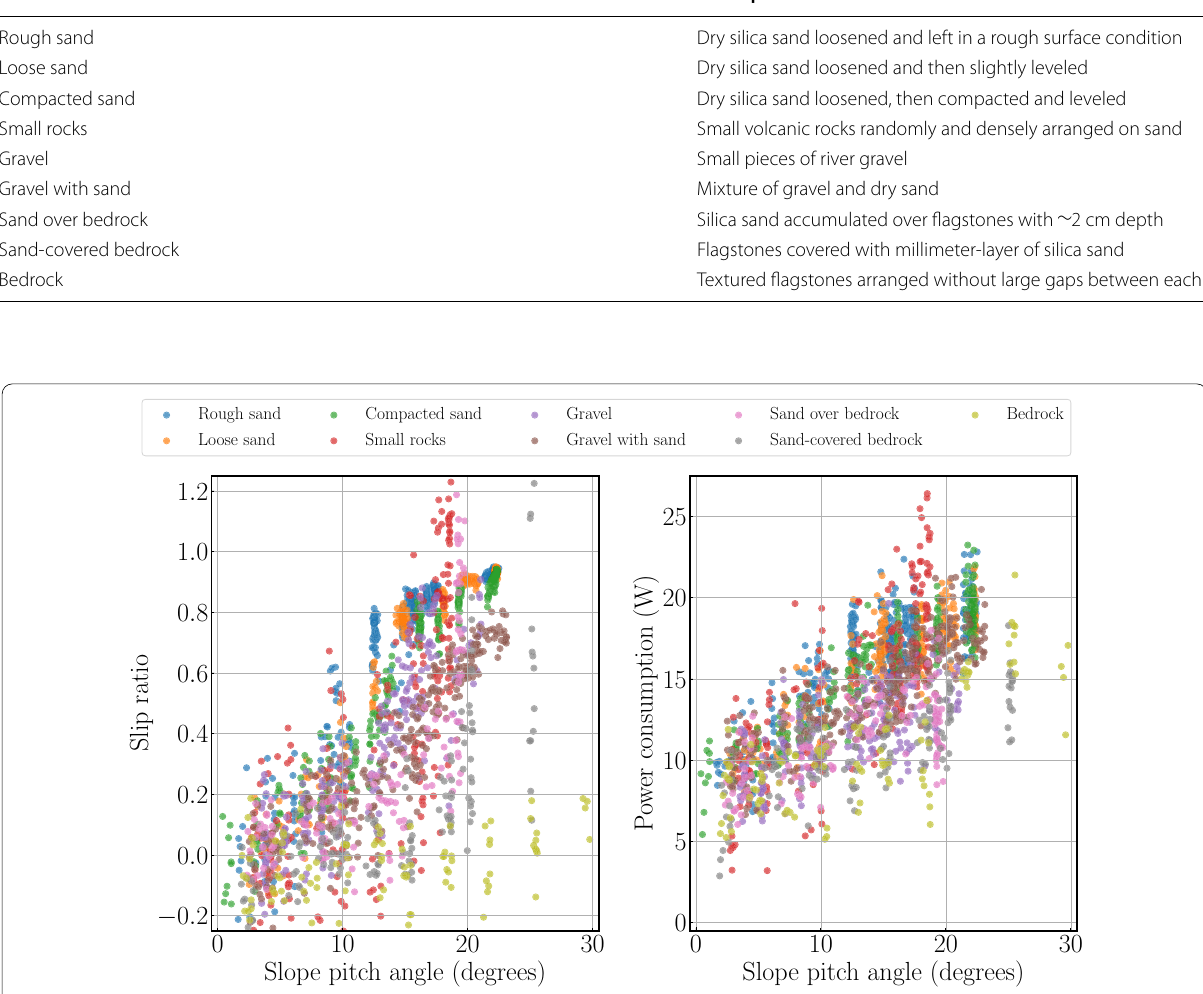
Table 1 Description of surface types used in the experiments Surface domain Description